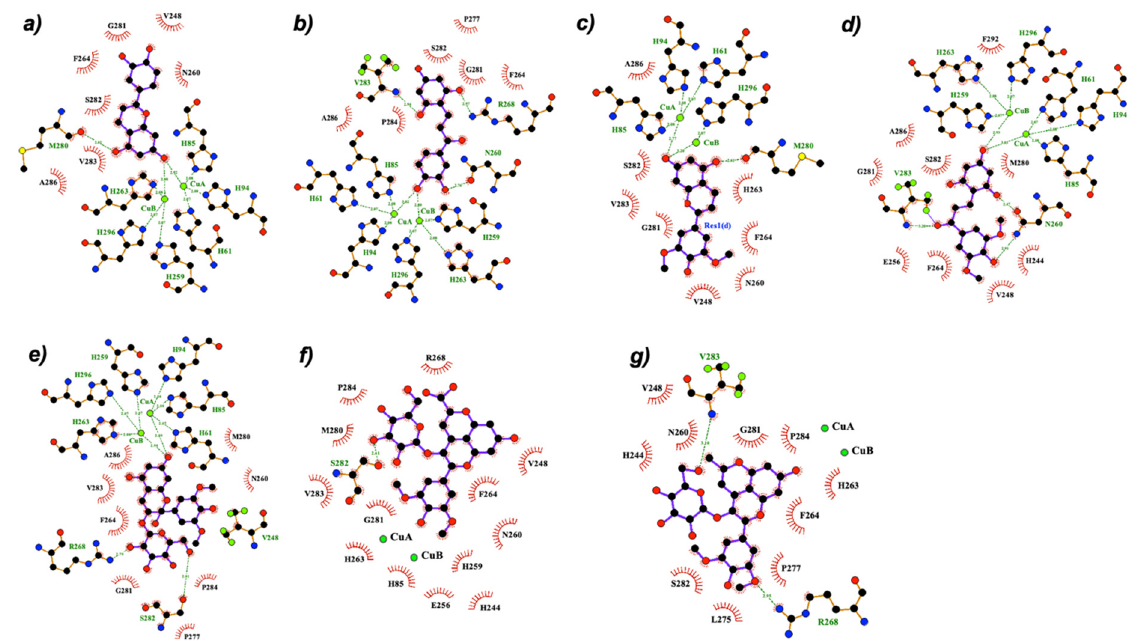
Figure 4. 2D representation of the best docking pose of some representative compounds towards the active site of mTYR: ( a ) 1-A, ( b ) 1-Ct, ( c ) 2-A, ( d ) 2-Ct, ( e ) 4-B − , ( f ) 6, and ( g ) 8. LigPlot was used for diagram rendering [45]. The 3D poses are depicted in Figure S2.